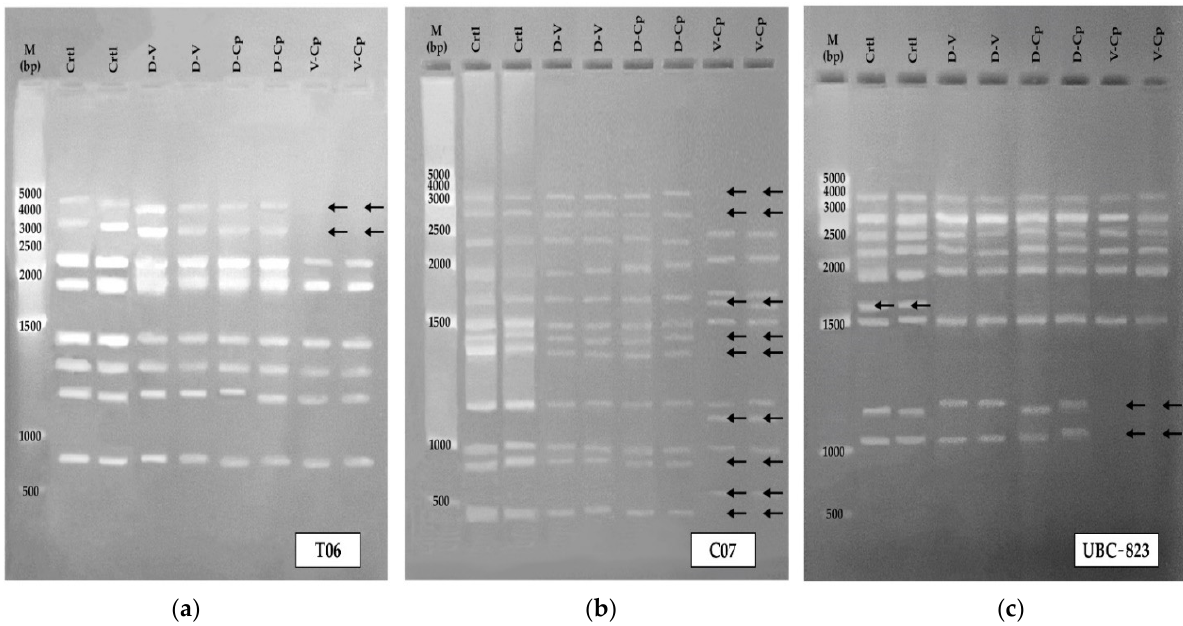
Figure 2. Electrophoretic patterns using ISSR primers ( a ) T06, ( b ) C07 and ( c ) UBC-823 of in vitro-derived controls and cryo-derived Vanilla planifolia plants during greenhouse culture. Arrows indicate presence or absence of polymorphic bands. M: molecular weight marker, Ctrl: control, D-V: droplet-vitrification, V-Cp: V-cryoplate, D-Cp: D-cryoplate.